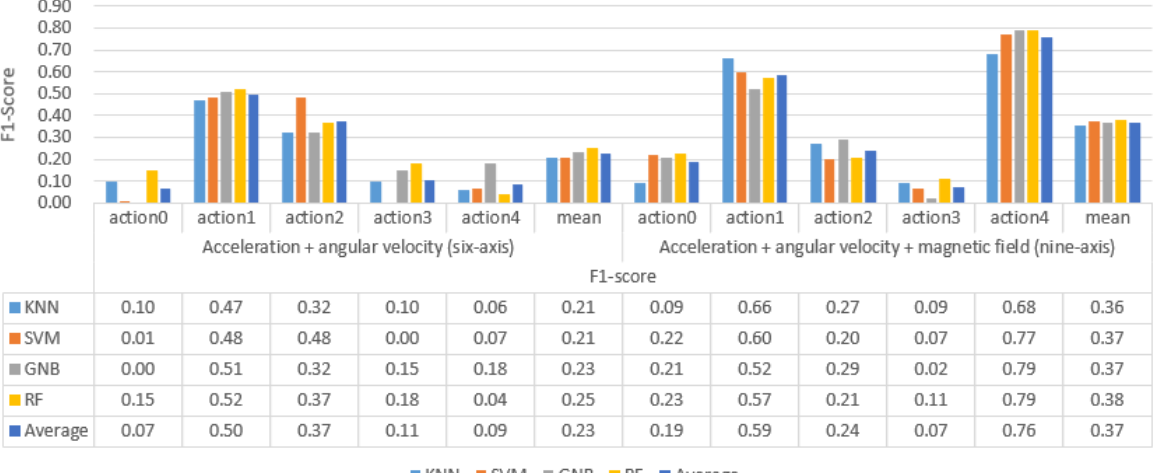
Figure 13. The recognition accuracy of traditional machine learning models based on artificial features on non-professional test sets.